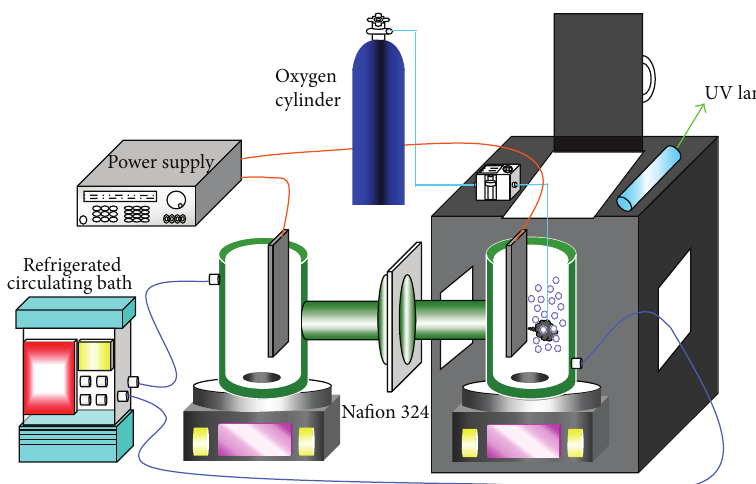
Figure 1: Schematic diagram of the paired photoelectrochemical oxidative